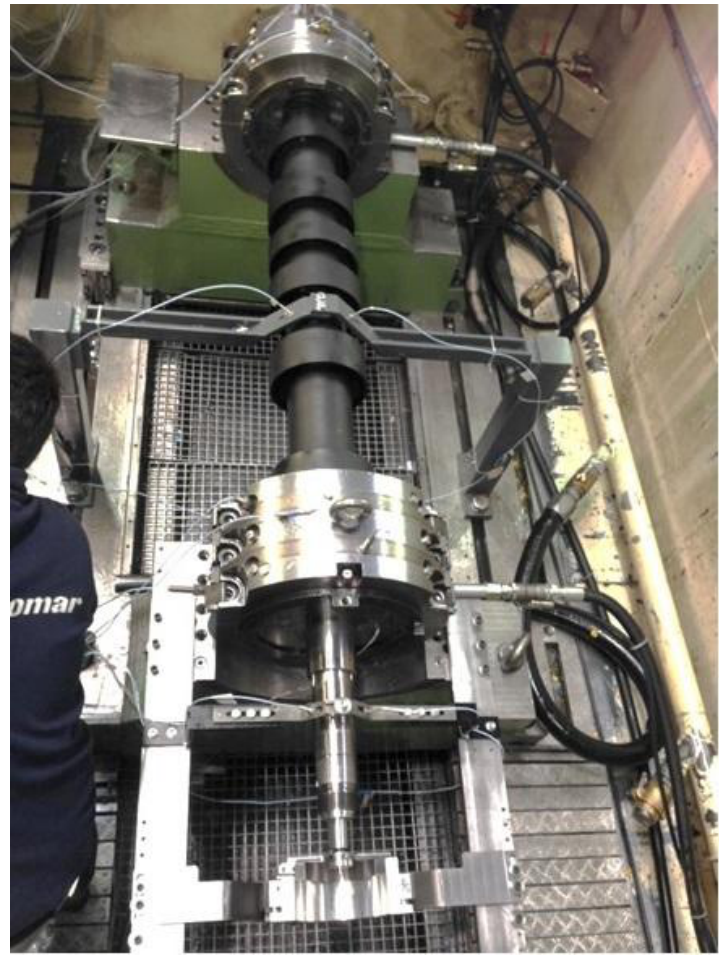
Figure 10. Test rig.